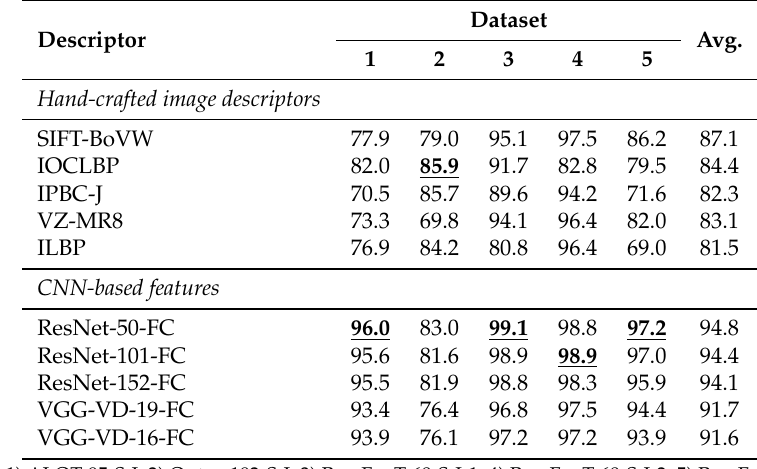
Table 9. Results of Experiment #3: stationary textures with variations in illumination. Figures report overall accuracy by dataset. Boldface denotes the highest value; underline signals a statistically-significant difference between the best hand-crafted and the best CNN-based descriptor. Descriptors are listed in ascending order of by-experiment rank (best